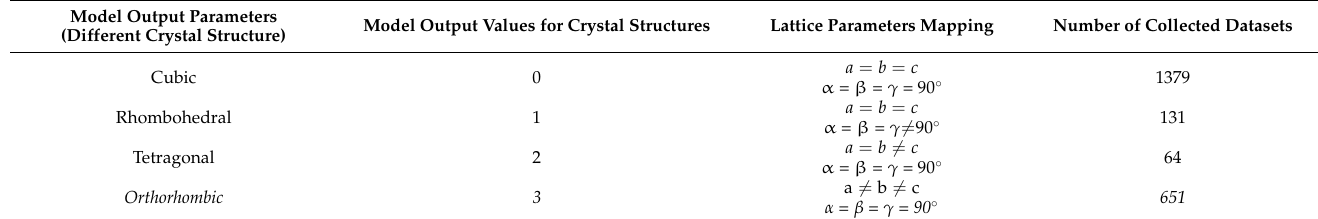
Table 2. Crystal structure representation.